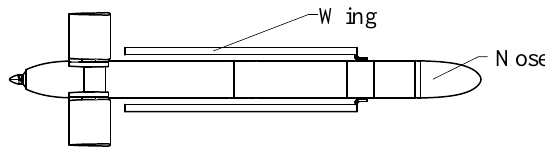
Figure 1. Folding mode 1.